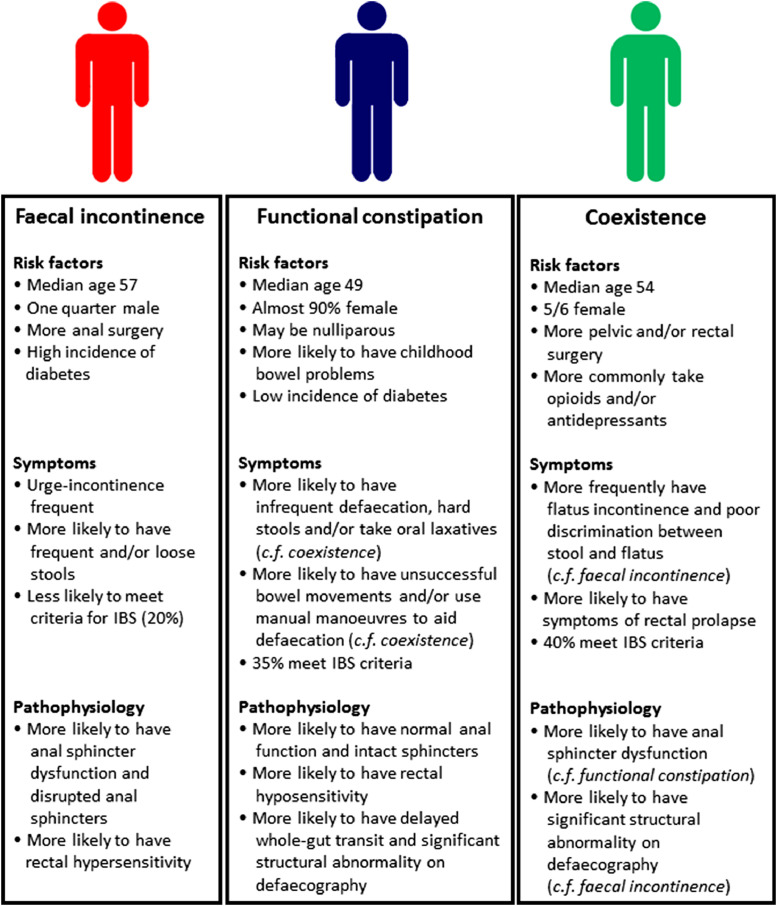
Broad phenotypic characteristics of patients in the 3 groups.